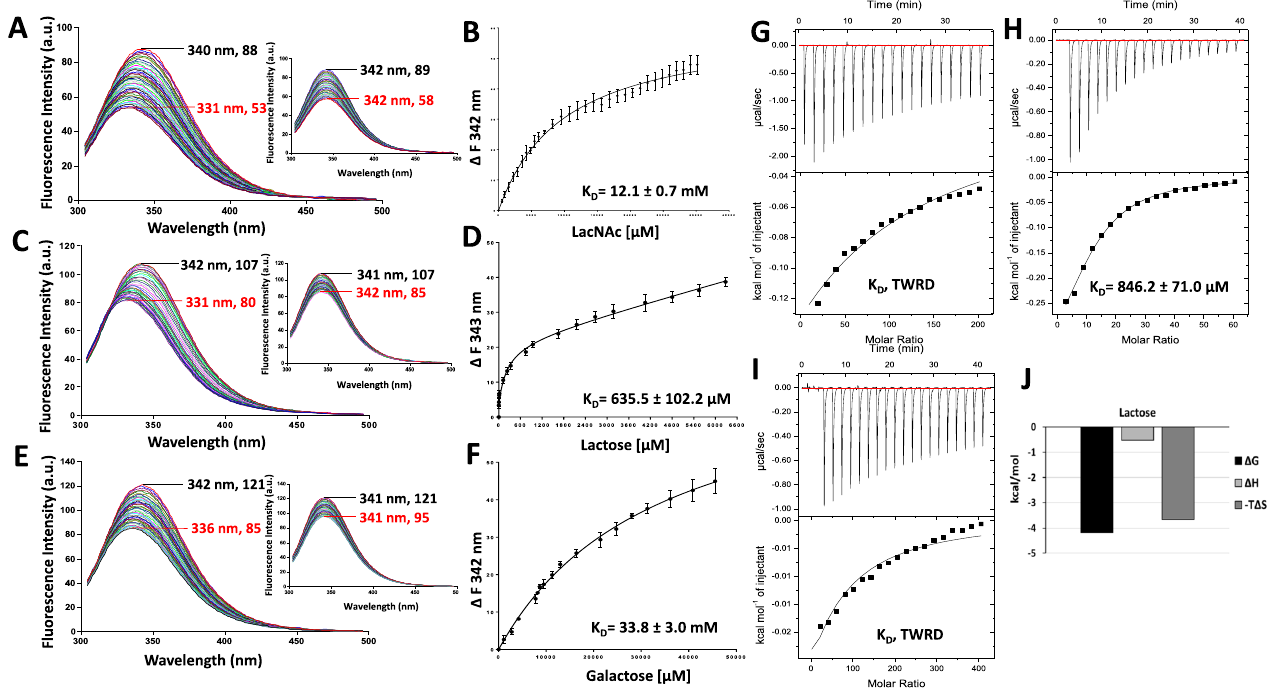
Figure 7. Determination of galectin-4C-ligand interactions by TFS and ITC. Galectin-4C (5 µ M) florescence intensity with increased concentrations of LacNAc ( A ), lactose ( C ) and galactose ( E ) were recorded by fluorescence spectroscopy. Numbers indicate the maximum fluorescence wavelength and corresponding fluorescence intensity for the first (no ligand/buffer titration, black) and last (red) titration traces. Inserts in each figure show buffer control titrations. Ligand concentrations vs changes in fluorescence intensity were plotted and analysed using One site- Specific binding model to obtain the binding affinities to LacNAc ( B ), lactose ( D ) and galactose ( F ). Heat changes for titration of galectin-4C (100 µ M) with 20 mM LacNAc ( G ), 30 mM lactose ( H ) and 200 mM galactose ( I ) were measured by ITC (upper panels) with data fit to One set of sites interaction model (bottom panels). Note the very small heat change by LacNAc ( G ) and galactose ( I ) which indicates very little, if any, binding taking place. Data were plotted as means ± SEM from three independent experiments for each assessment. Panel (J) shows thermodynamic profiles with enthalpy ( ∆ H), entropy ( ∆ S) and Gibbs free energy ( ∆ G) changes associated with galectin-4C binding to